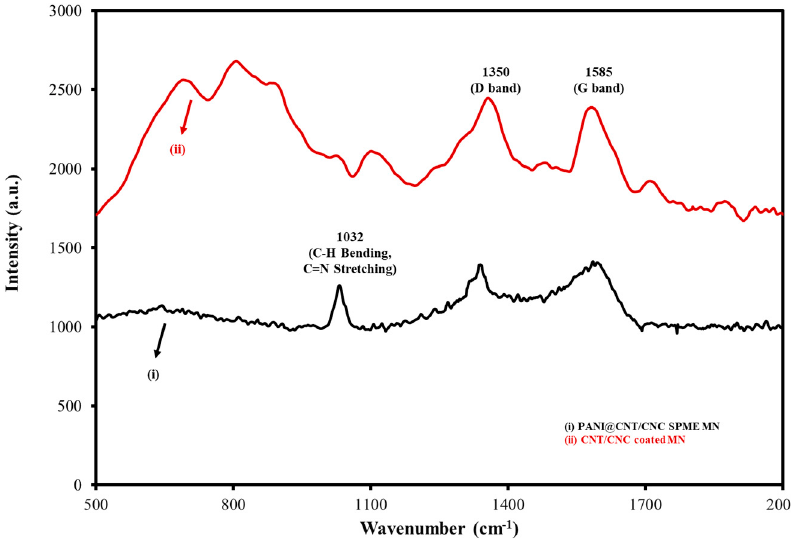
Figure 3. Overlaid Raman spectra for (i) PANI@CNT/CNC and (ii) CNT/CNC SPME